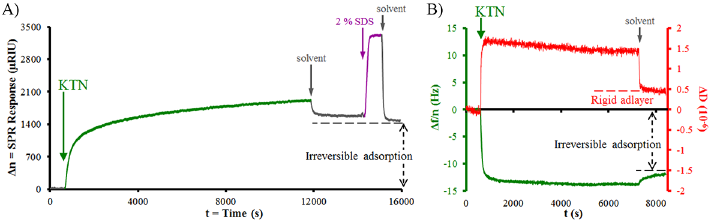
Fig 5. Interface behavior. Adsorption kinetics of KTN on gold analyzed through A) SPR and B) QCM-D methods. After establishing baseline readings using 10 mM NaOH solvent, KTN solution was flowed on gold sensor chips until almost full saturation. A) The irreversible adlayer at SPR response ( Δ n) = 1410 μ RIU was retained after solvent, 2% SDS, and solvent washings, and its surface concentration ( Γ ) = 2.49 mg/m2. B) The normalized changes in dissipation factor ( Δ D) for the adsorbate = 0.46 × 10 – 6 (red curve, using the right y-axis), suggest rigidity. The changes in frequency per overtone ( Δ f/n) of the adsorbed KTN = -12.08 Hz (green curve, using the left y-axis), correspond to a surface concentration ( Γ ’ ) = 2.14 mg/m2. A comparison between Γ (SPR) and Γ ’ (QCM-D) showed statistical similarity (p =